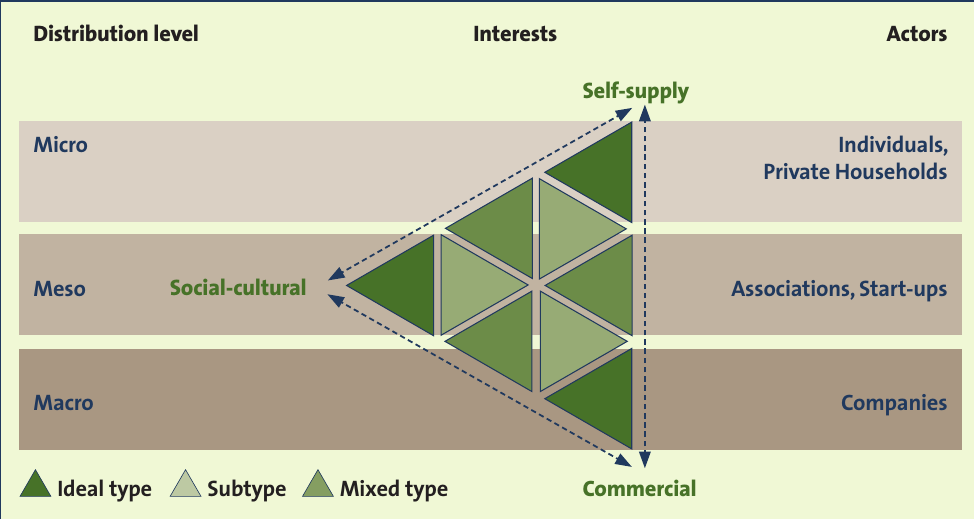
Figure 1. Triangle graph of ideal, subtypes and mixed types of UA, according to the distribution level of the produce, the involved actors and the predominant